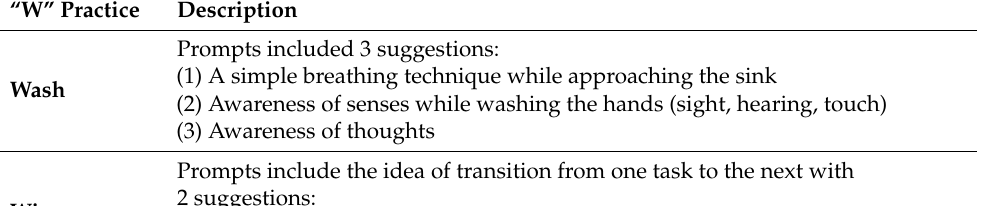
Table 2. The Ws of Awareness: Quick Response Nurse Pocket Guide *. “W” Practice